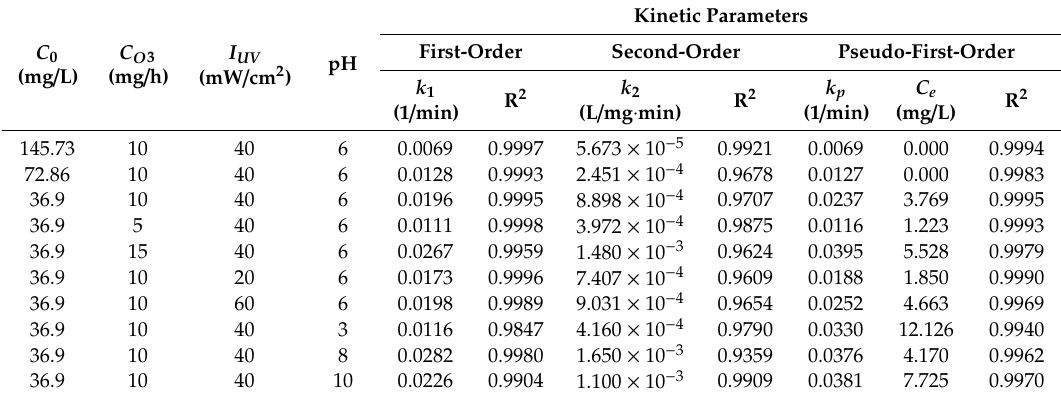
Table 1. Kinetic parameters of the first order, second-order, and pseudo-first-order models.